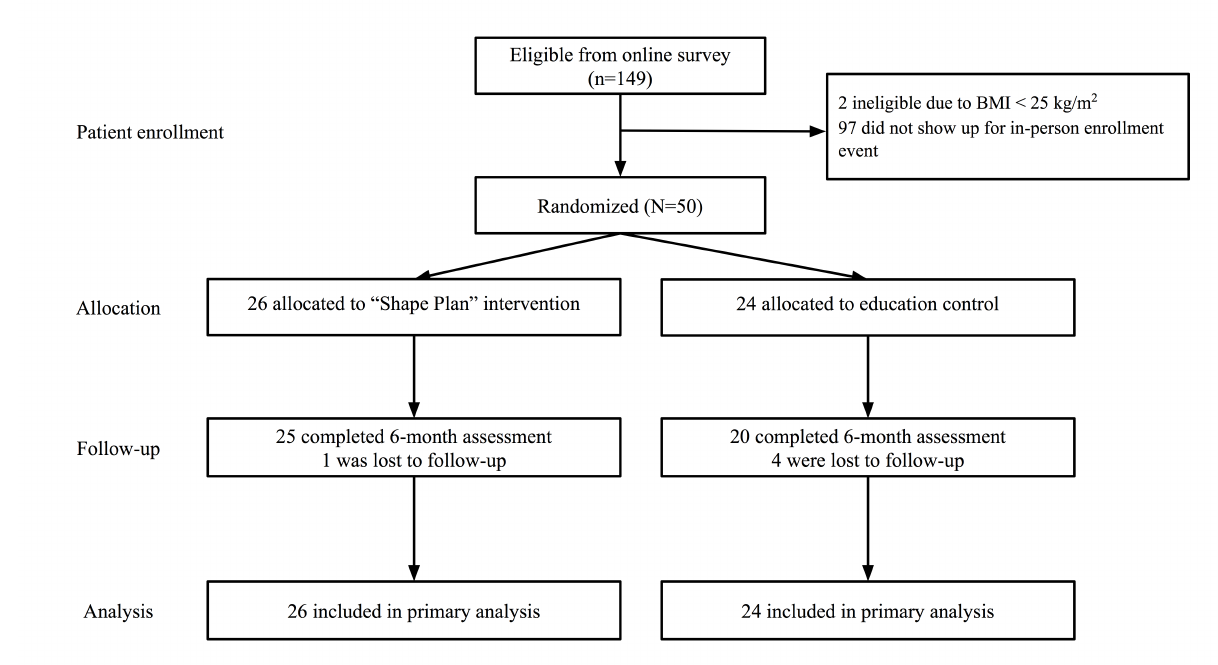
Figure 2. Flowchart of participant enrollment and retention in the